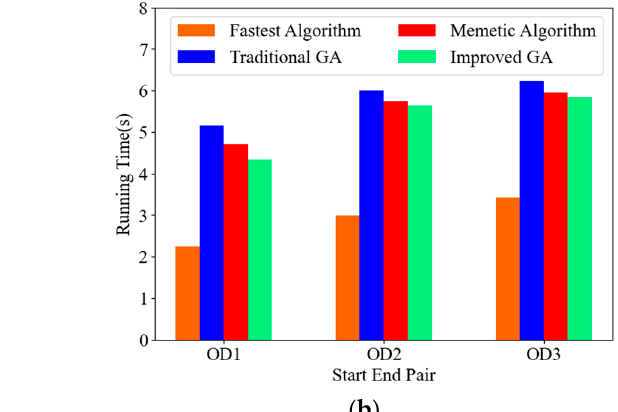
Figure 9. Comparison of the running time of the algorithm under different start end pairs. ( a ) Xi’an; ( b ) Wuhan.